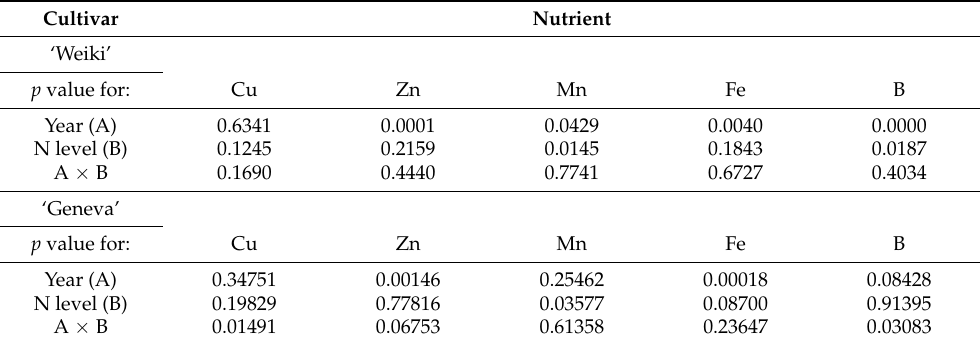
Table 5. Statistics: values of p for particular sources of variation and their interaction depending on the micronutrient and cultivar tested (FRUIT